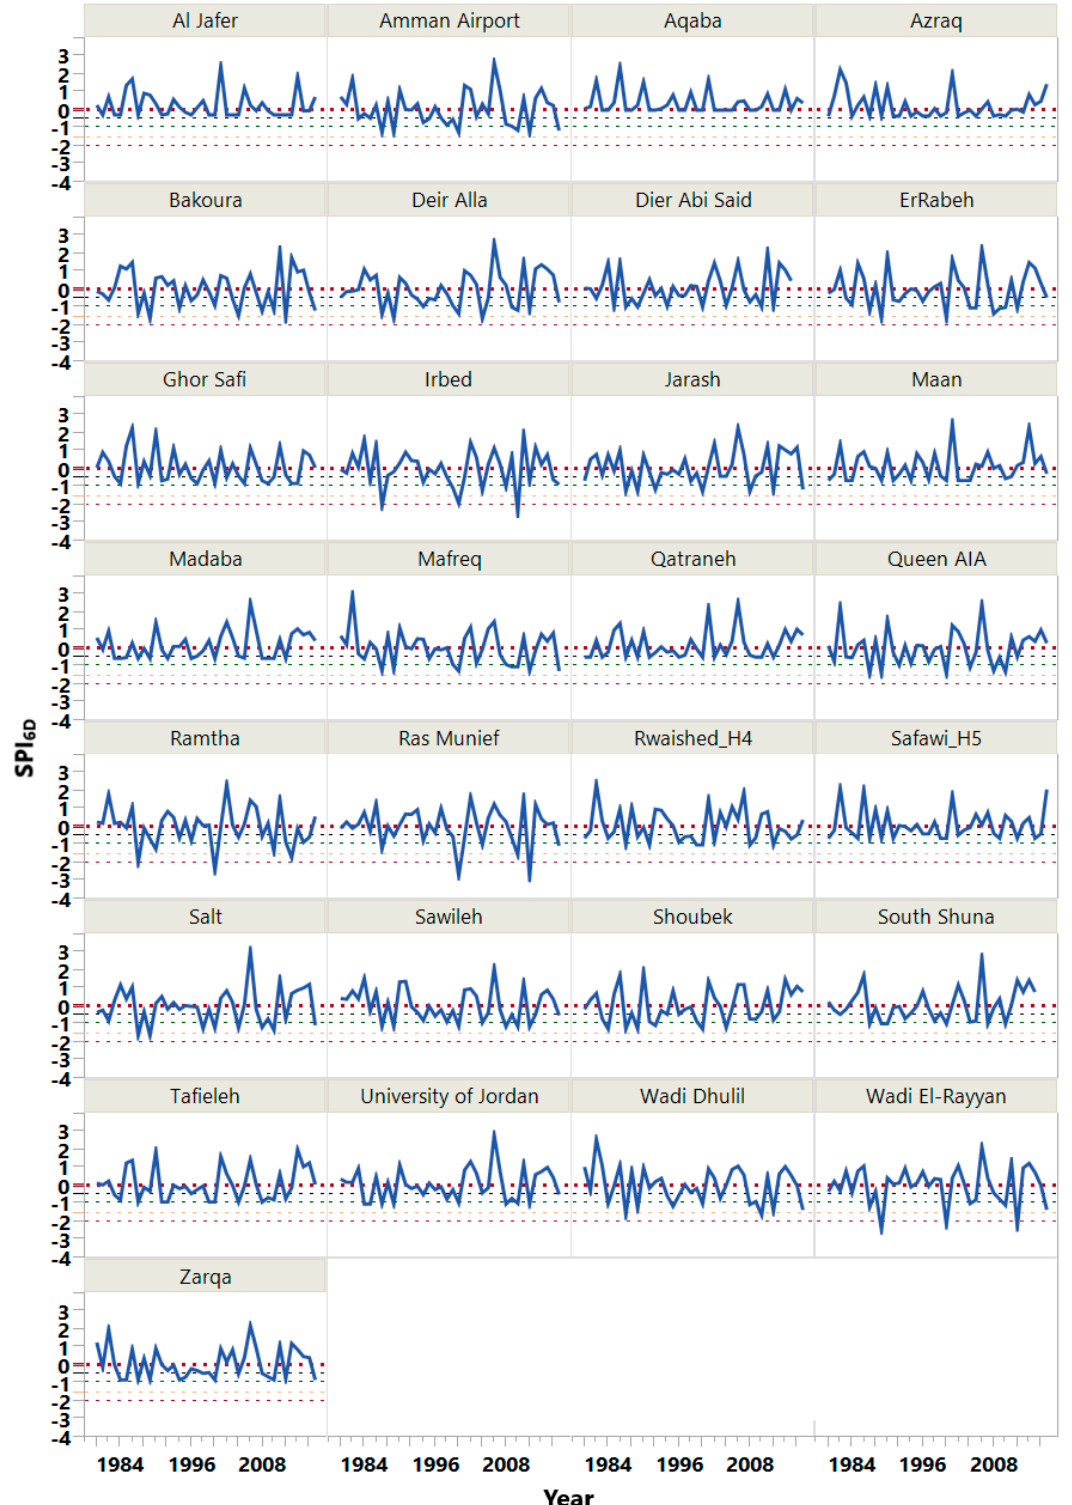
Figure 5. Dry season standardized precipitation index (SPI 6D ) values for each station from 1980 to 2017.